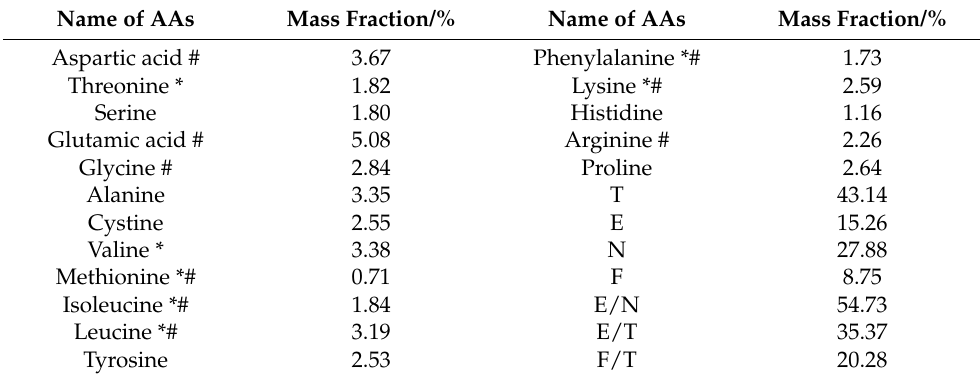
Table 1. Composition and mass fraction of AAs in PA